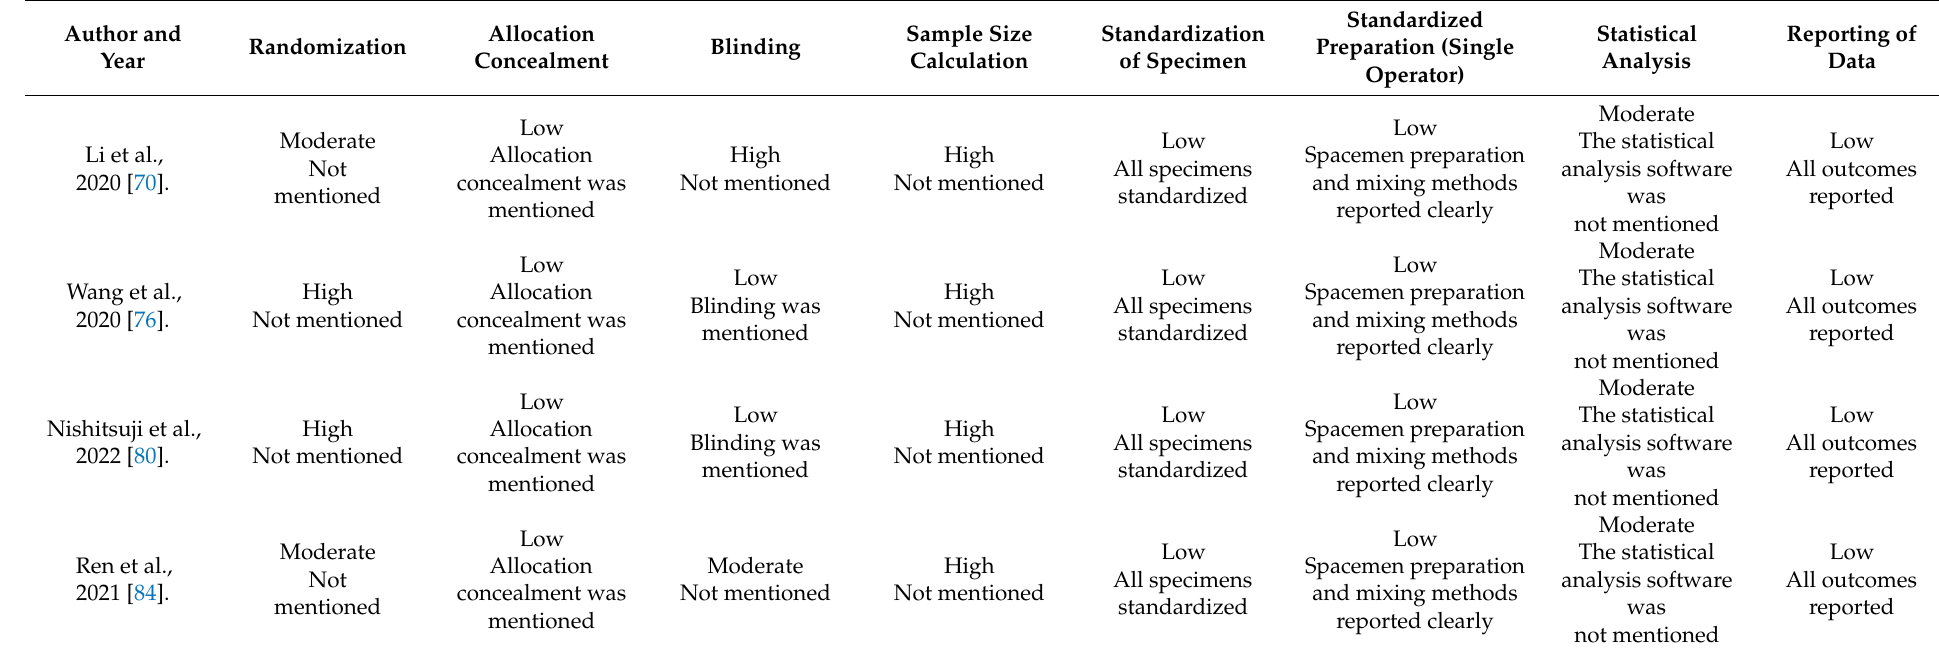
Table 2. Risk of bias in the implementation and reporting of data from in vitro